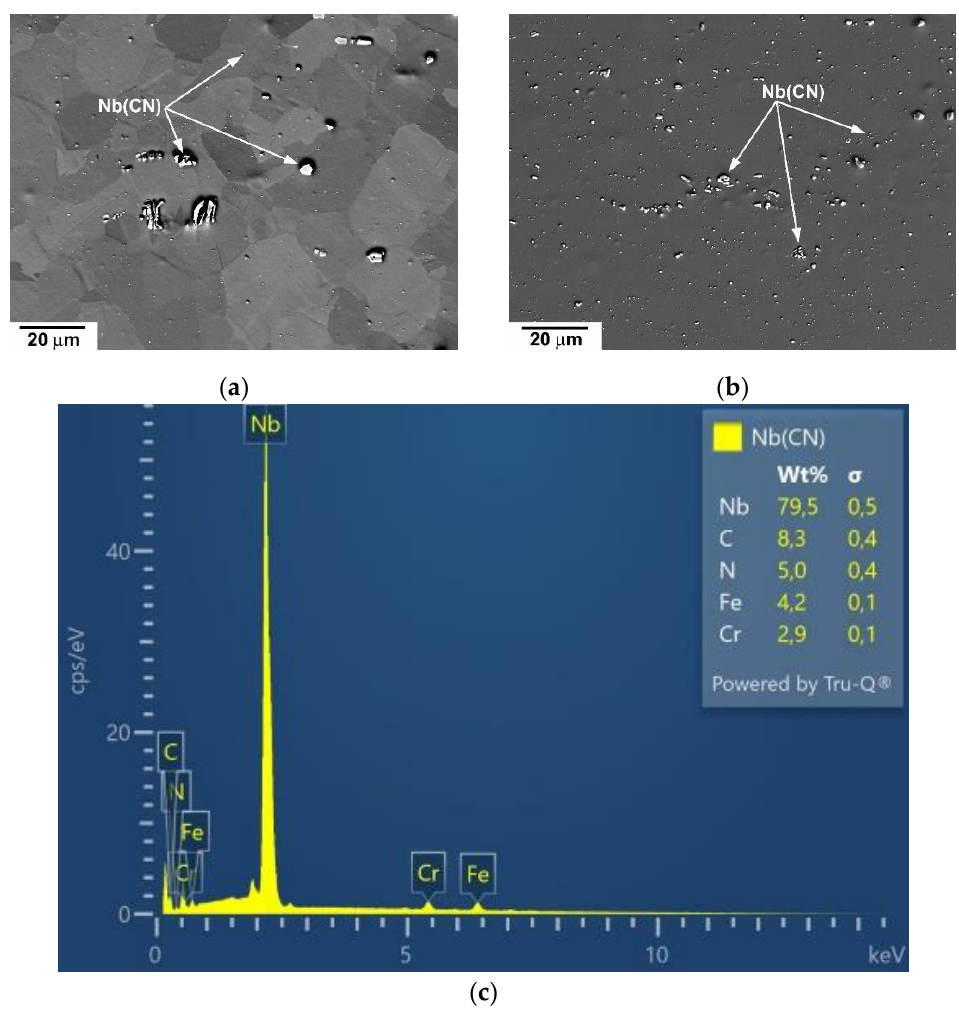
Figure 2. Nb carbonitrides in microstructure of S304H steel before creep testing ( a ) CG state, ( b ) HPs-processed state and ( c ) chemical composition of Nb carbinitrides.